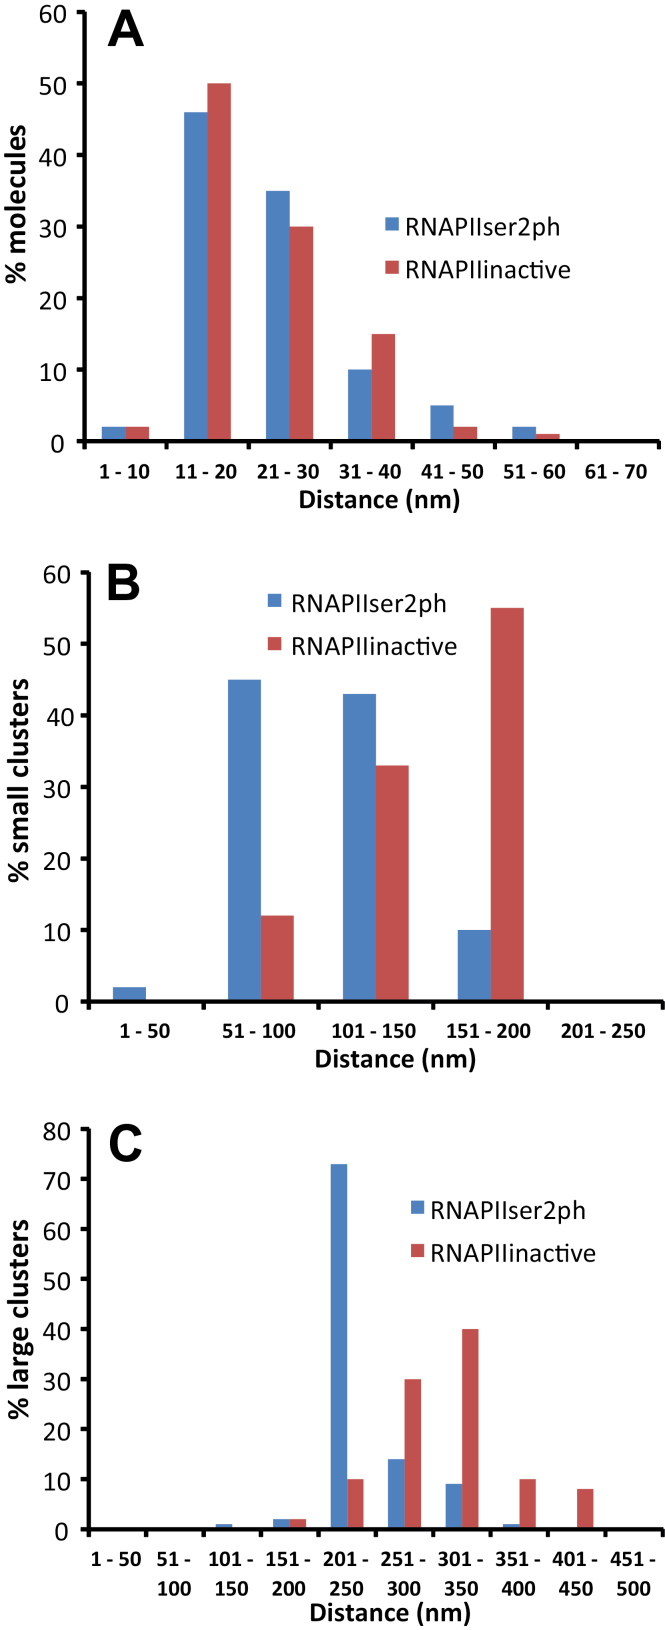
Distances between single molecules (A), small (B), and large clusters (C).